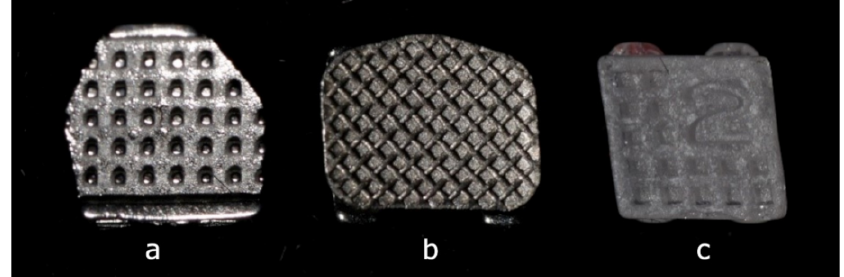
Figure 1. Types of brackets tested in the study: ( a ) Cannon System metal bracket (bracket base with anchor pylons), ( b ) Victory Series 3M metal bracket (bracket base with foil mesh), ( c ) Backlight ceramic bracket (bracket base with retention